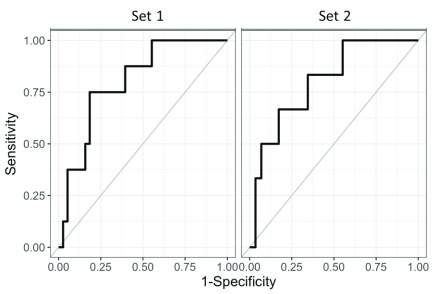
Receiver-operating characteristic (ROC) curves for the best performing candidate.ROC curve of NPTXR protein in set 1 and set 2; area under the curve value for set 1 was 0.799 (95% CI: 0.628, 0.928) and in set 2 was 0.799 (95% CI: 0.586, 0.960).